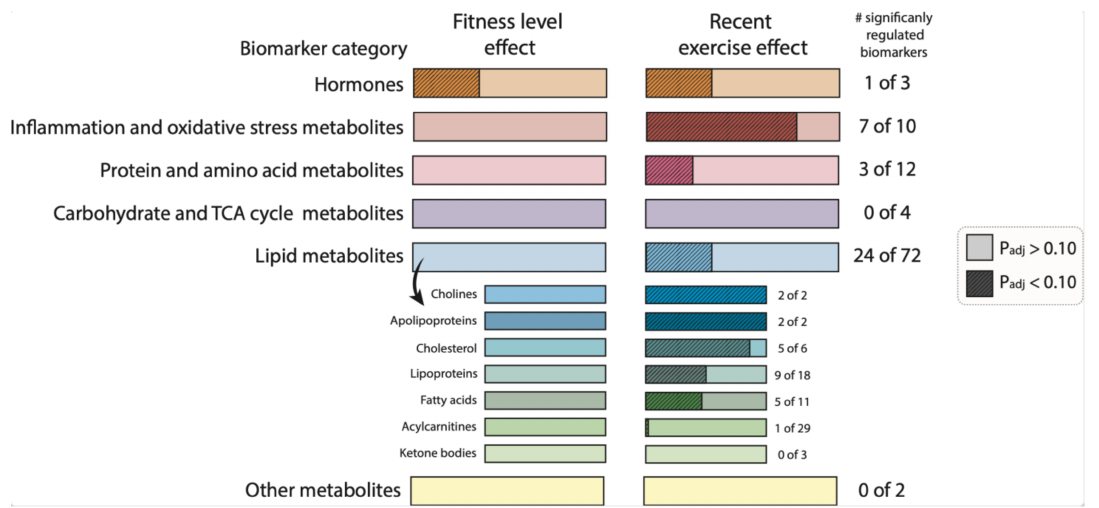
Figure 3. The effect of fitness level and a recent exercise bout on biomarkers and metabolic param- eters category responses. Graphical summary representing the number of significantly regulated biomarkers and metabolic parameters between high-fit and low-fit females (fitness level effect, left bars) and the number of significantly regulated biomarkers and metabolic parameters between baseline and post-exercise (recent exercise effect, right bars). Non-significant effects (adj.Pgroup or adj.Pexercise > 0.10) are depicted in light-coloured bars and significant effects (adj.Pgroup or adj.Pexercise < 0.10) are depicted in dark-coloured, dashed bars. The filled area is calculated relative to the number of biomarkers and metabolic parameters within the corresponding functional